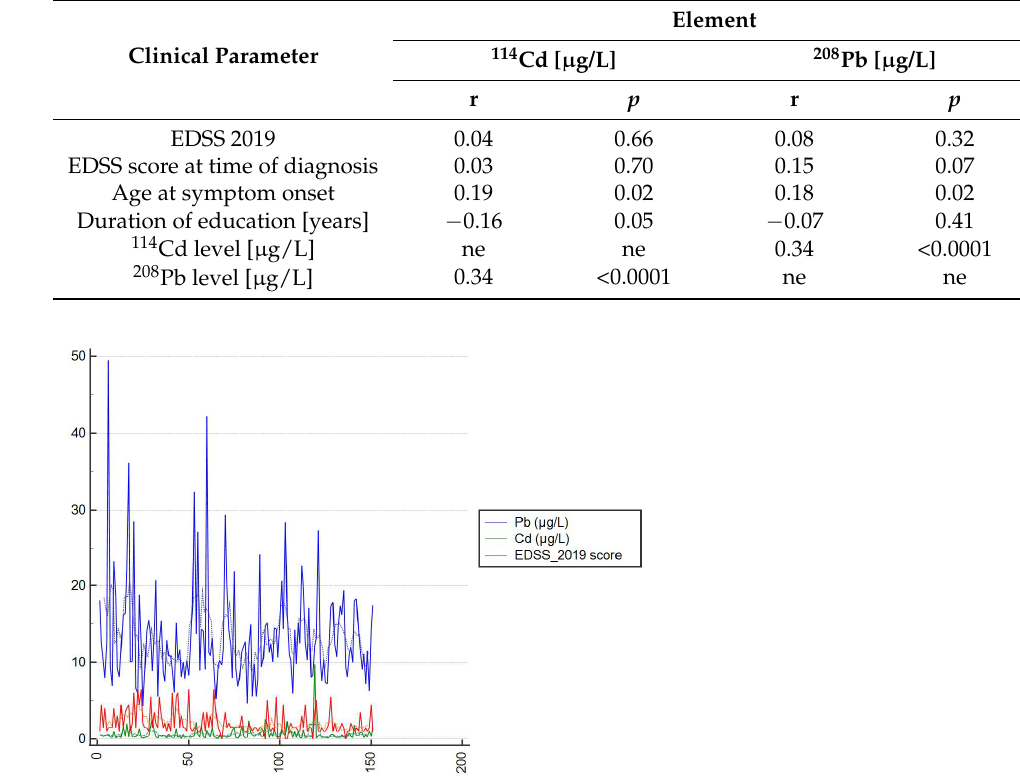
Table 3. Correlations between the levels of the tested elements and selected clinical and demographic variables. ne—not estimated.